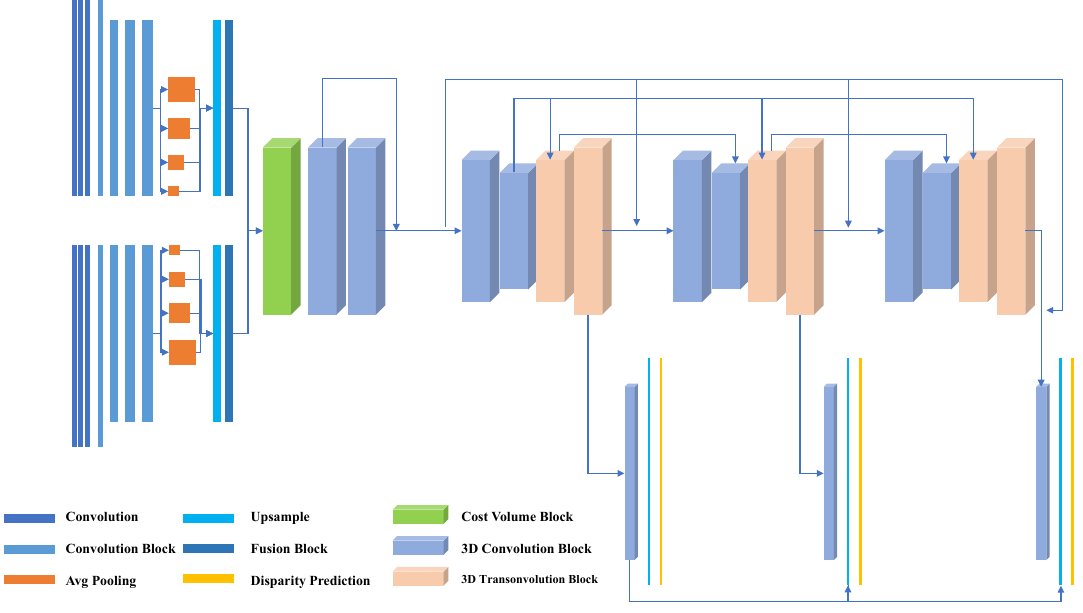
Figure 3. Architecture of